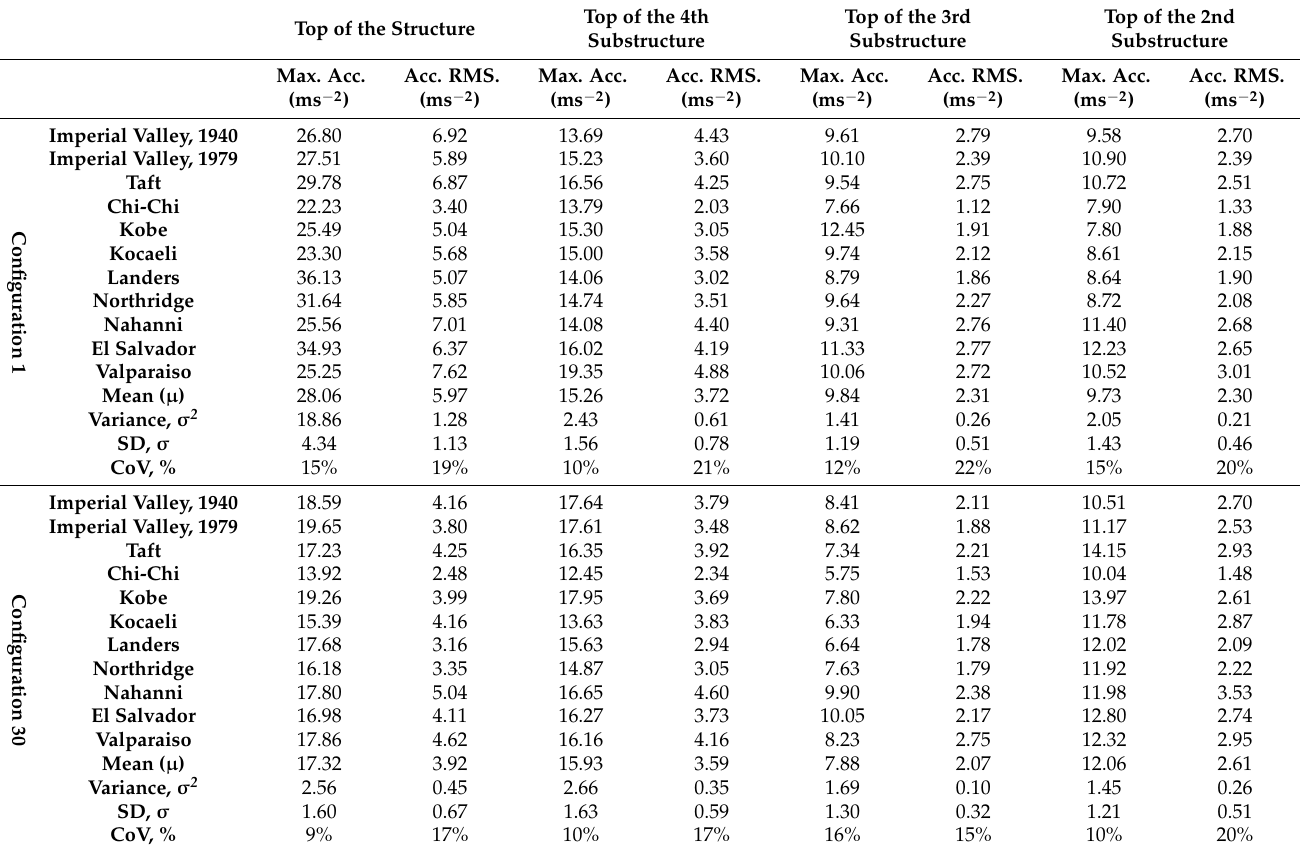
Table 5. Max. Floor Acceleration at the Main Points of Structure.